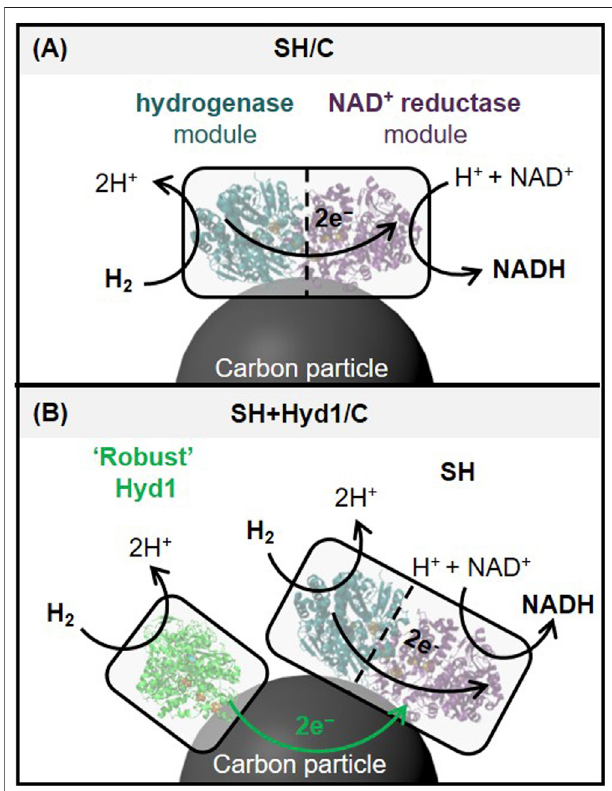
FIGURE 2 | Illustration of the proposed boosting effect on NADH regeneration achieved by immobilizing a more active and robust hydrogenase (Hyd1) alongside SH on carbon. (A) Soluble hydrogenase consists of distinct modulesforH 2 oxidation(hydrogenase,darkgreen)andNAD + reduction (NAD + reductase, purple), with electron transfer between the modules facilitated by a chain of internal iron-sulfur electron relay centers. In this work, the SH is used as a heterogeneous biocatalyst by adsorption onto carbon particles. (B) Co-immobilization of an additional robust hydrogenase (Hyd1, lightgreen)mayprovideadditionalH 2 -derivedelectronsthroughthecarbonto the NAD + reductase module, to supplement the relatively low activity and instability of the hydrogenase module of the